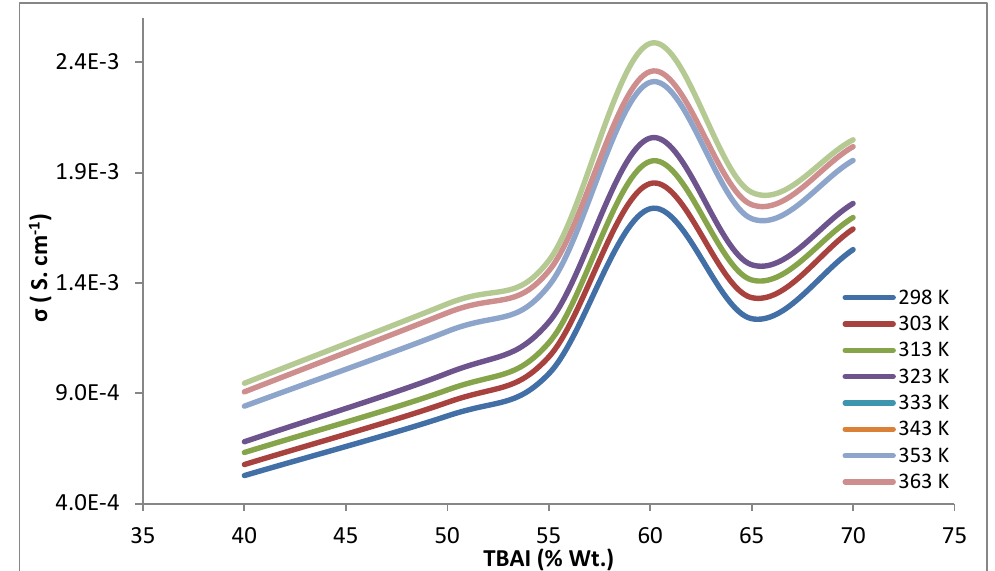
Fig. 2: Dependence of ionic conductivity on TBAI weight ratio for the gel polymer electrolytes.